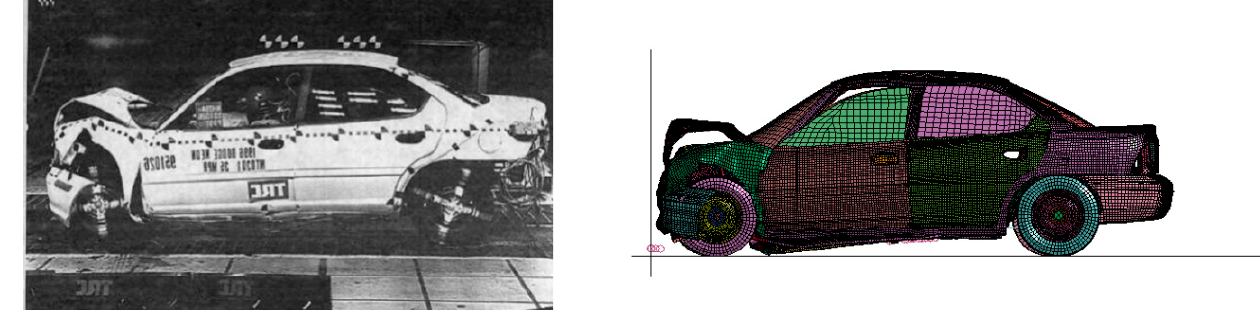
Figure 8. Comparison of snapshots of a frontal, rigid wall collision.